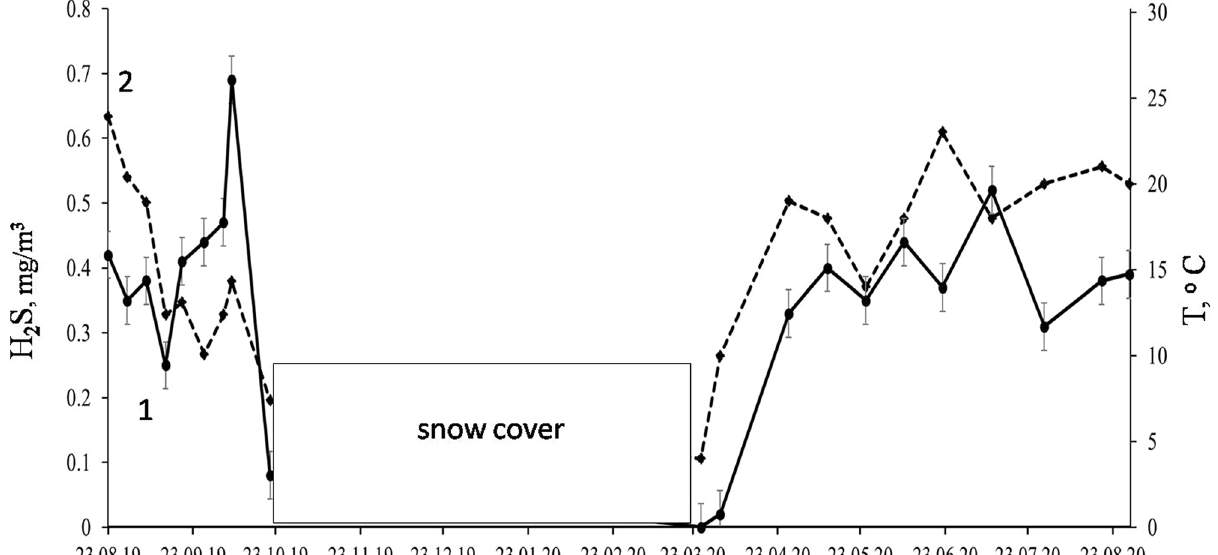
Figure 2. Time course of hydrogen sulfide levels (1, solid line) and ambient air temperature (2, dashed line) at the solid–liquid separation lagoon (Tom1). H 2 S concentrations in air were measured via an OKA-T portable gas analyser with electrochemical sensor (accuracy of ± 25% of reading). Vertical bars show the standard deviation calculated from three readings.